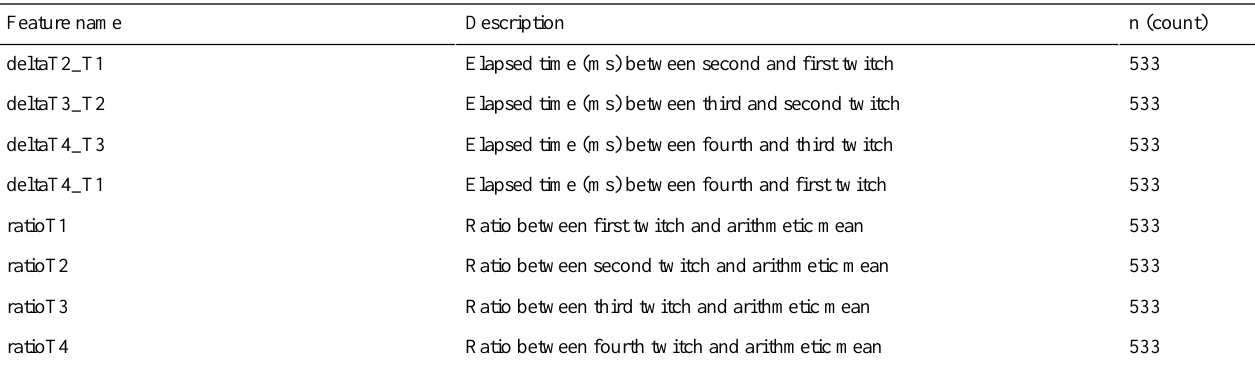
Table 2. Description of engineered features of data set.